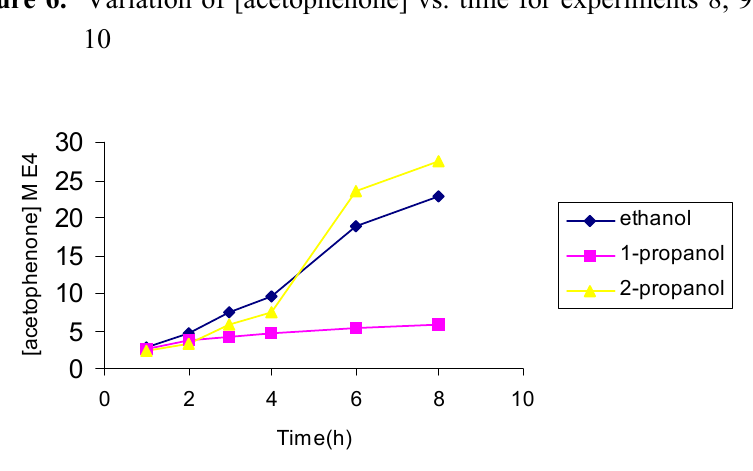
Figure 6. Variation of [acetophenone] vs. time for experiments 8, 9 and